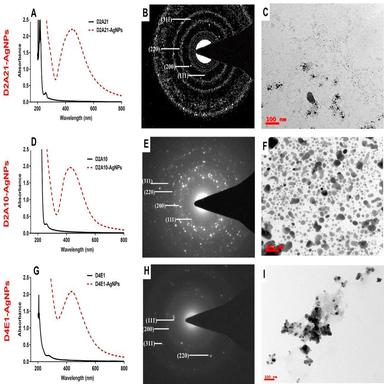
Characterization of P-AgNPs (D2A21-AgNPs, D2A10-AgNPs and D4E1-AgNPs) by UV–visible spectroscopy and TEM analysis. UV–visible spectra of P-AgNPs: native peptide D2A21 (240 μM), D2A21-AgNPs at peptide concentration of 240 μM and pH 8 with 5 mM AgNO3 (A); native peptide D2A10 (240 μM), D2A10-AgNPs at peptide concentration of 240 μM and pH 7 with 5 mM AgNO3 (D); native peptide D4E1 (60 μM), D4E1-AgNPs at peptide concentration of 60 μM and pH 7 with 5 mM AgNO3 (G); SAID pattern of D2A21-AgNPs (B), D2A10-AgNPs (